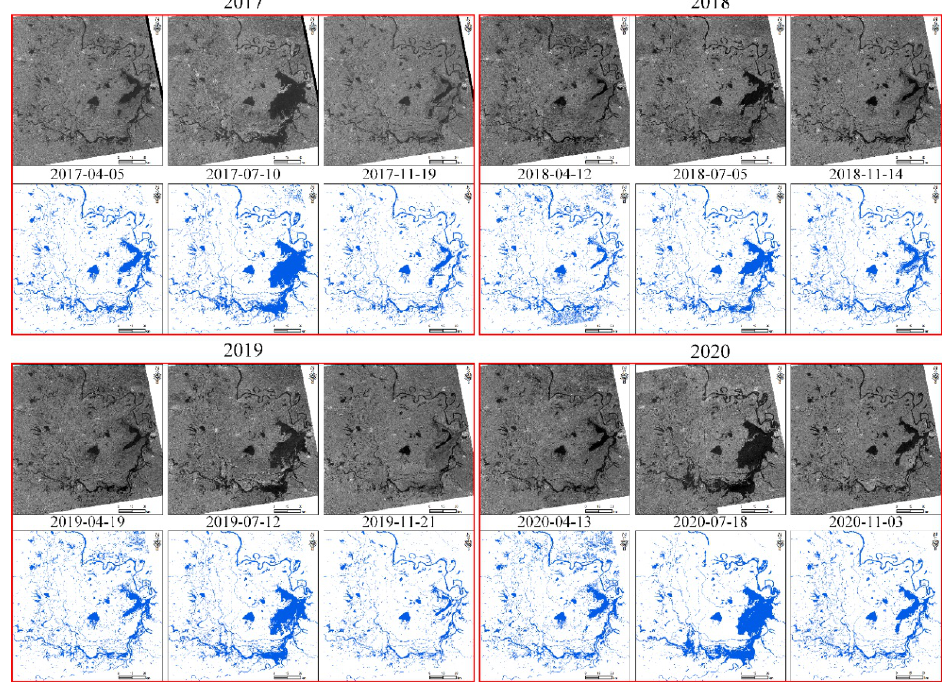
Figure 10. Results of Dongting Lake pre-, during- and post-flood in 2017–2020.